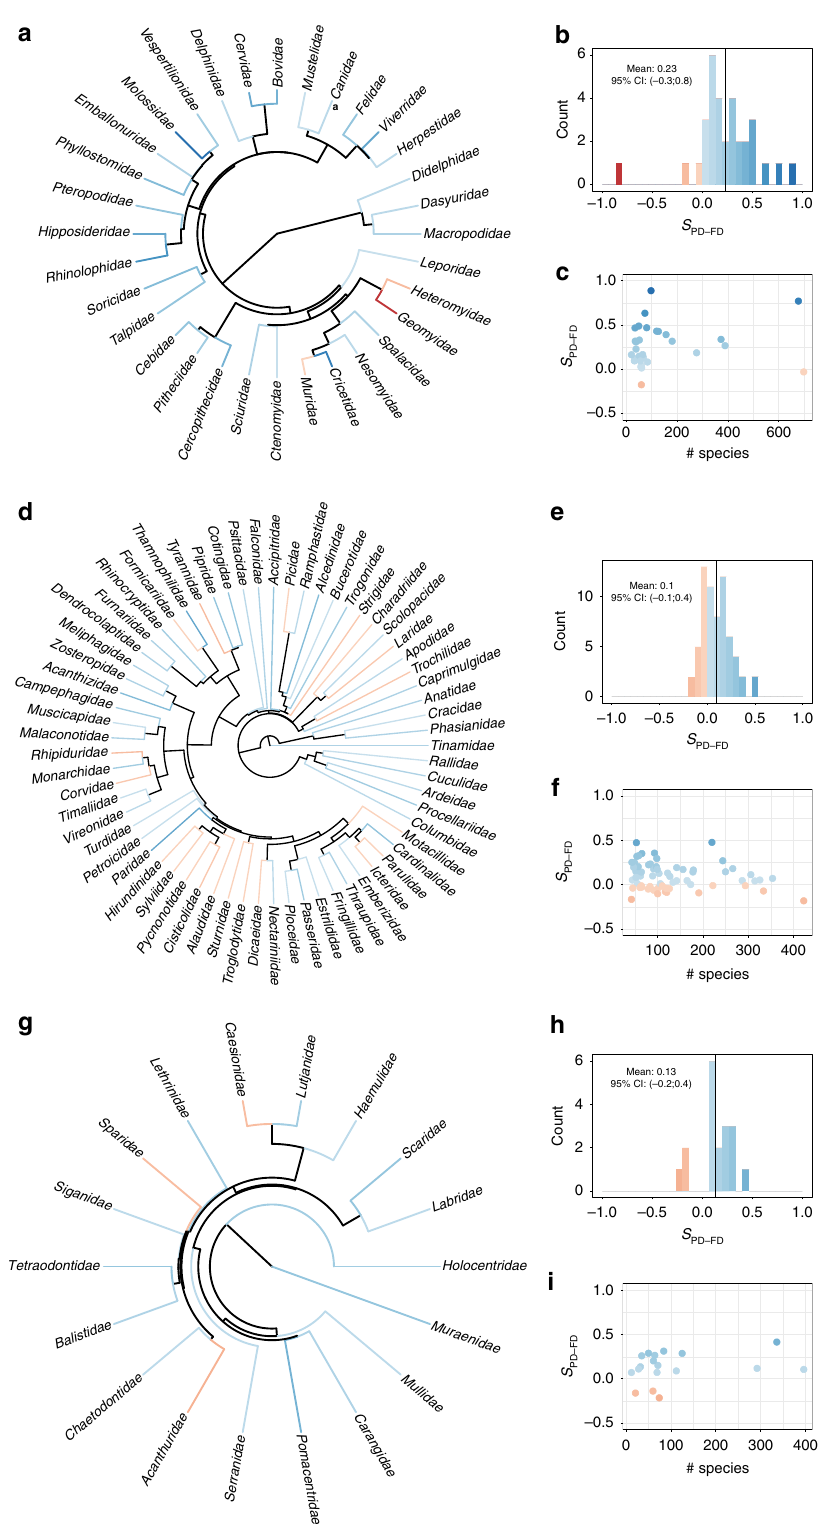
Fig. 3 PD is a good surrogate for FD across clades. The fi gure presents the distribution and correlates of S PD – FD for mammals ( a – c ), birds ( d – f ) and fi shes ( g – i ) across families. For each of the three groups, the S PD – FD frequency distribution is presented ( b , e ) along with its mean (vertical line). The color scheme is common to all panels. S PD – FD phylogenetic distribution is presented in panels a, d and g . Relationships between S PD – FD and species pool richness are presented in panels c , f , and i . For each taxonomic family, S PD – FD values are based on the mean over 1000 repetitions of random and maxPD set draw (there is only one maxFD set). The animal silhouette images in this fi gure were created by the corresponding author in Adobe